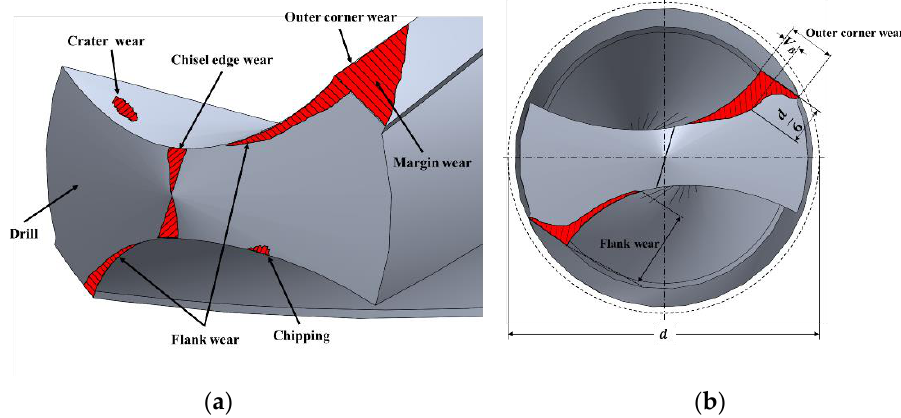
Figure 1. ( a ) Classification of drill bit wears; ( b ) comparison between flank wear and outer corner wear.